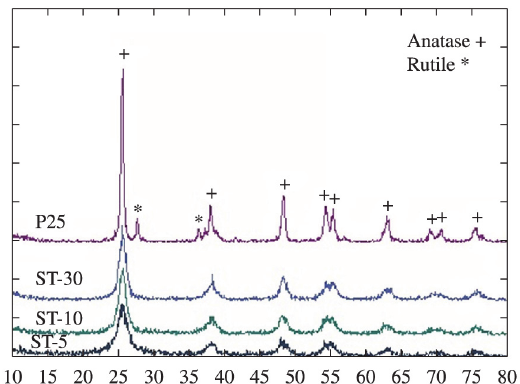
Figure 1. X-ray diffraction spectra of carbon-coated TiO2 and pure